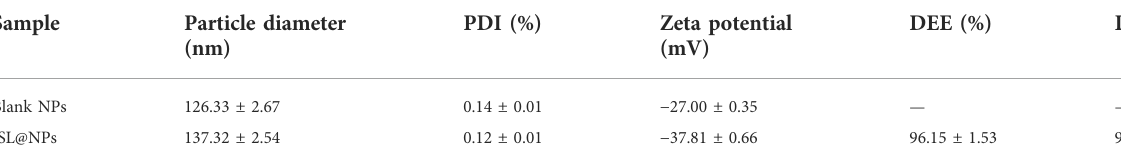
TABLE 1 Physicochemical characteristics of blank NPs and ISL@NPs ( n = 3).